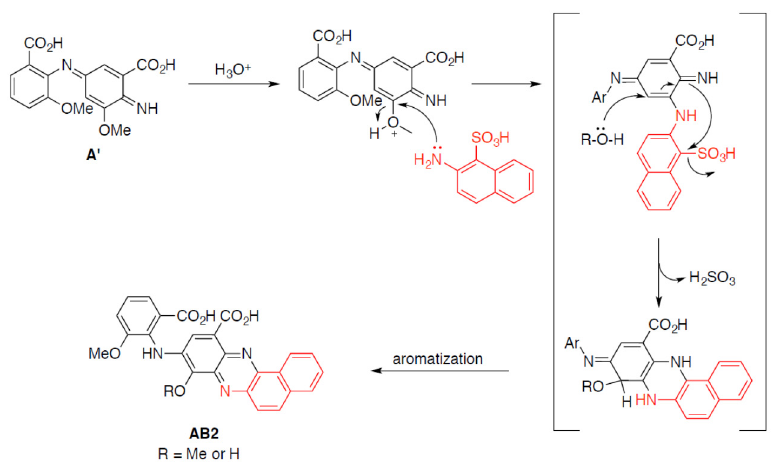
Figure 9. Proposed mechanism of heteromolecular coupling reaction of A’ dimer and B2 substrate (marked in red) during AB2 dye synthesis.